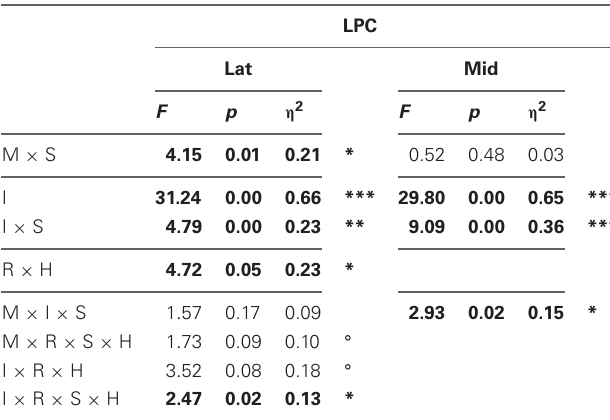
Table 3 | Results of the omnibus lateral (Lat) and midline (Mid) ANOVAs for the LPC (probe vs. irrelevants,